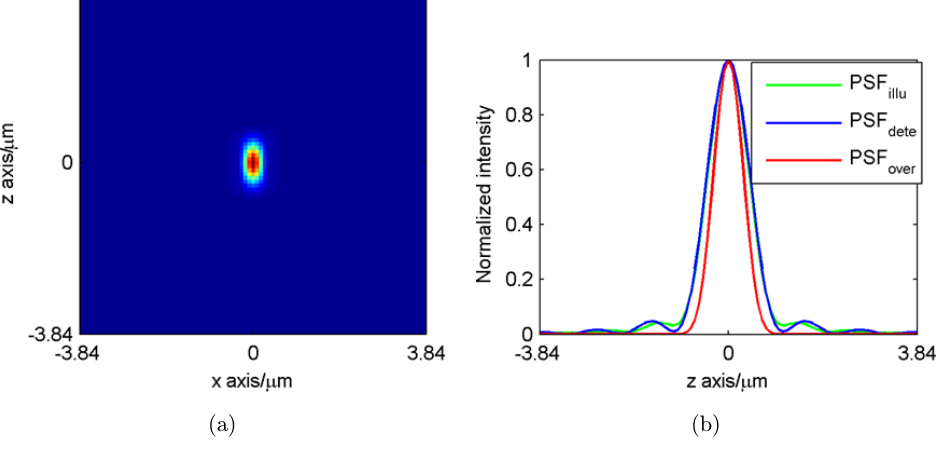
Fig. 12. The intensity distribution of Gaussian light